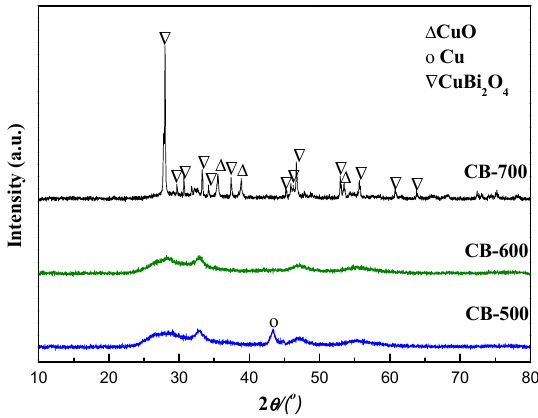
Figure 7. XRD pattern of used CuO-Bi 2 O 3 catalysts.